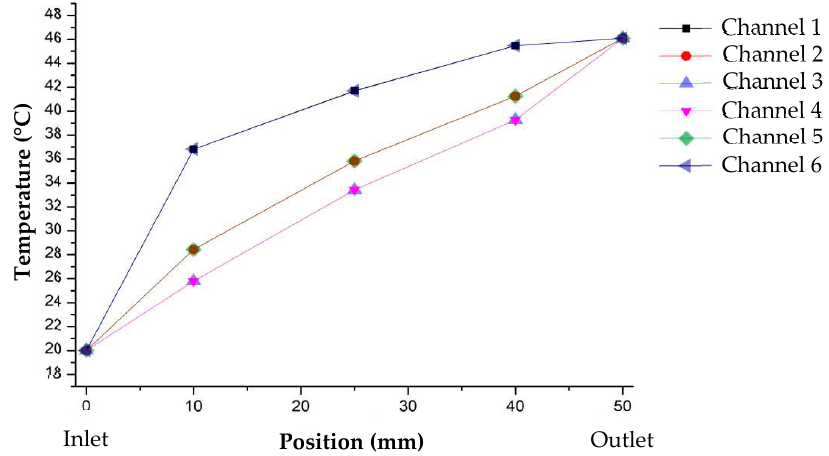
Figure 7. Temperature evolution throughout each channel, from the entrance to the exit, with a fluid flow of 1 mL/min.